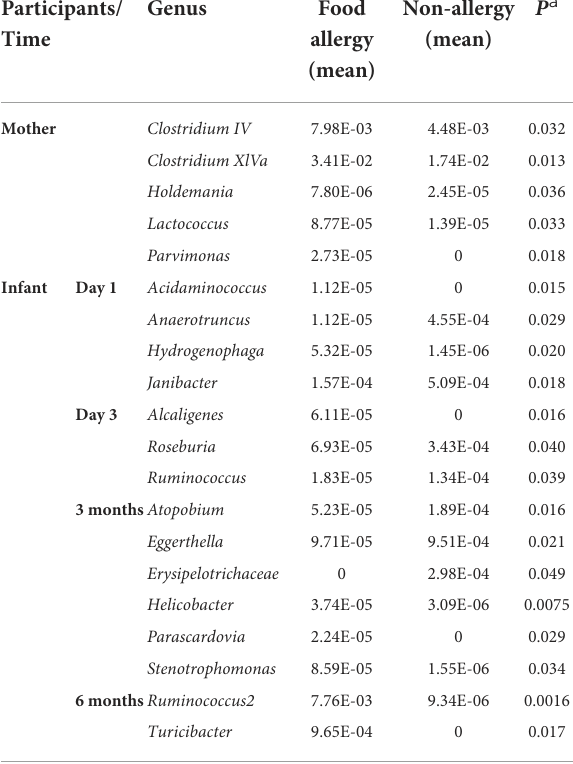
TABLE 3 Comparison of gut microbiota at the genus level between the non-allergy and food allergy groups.